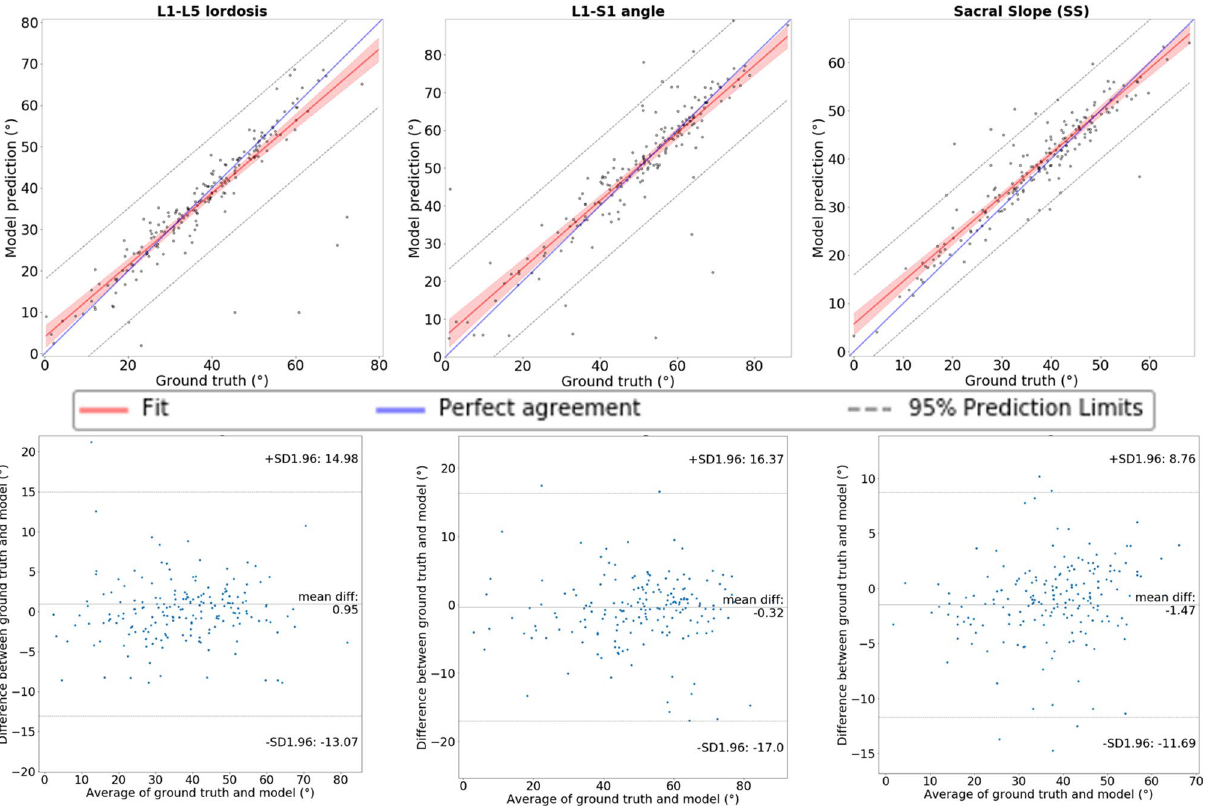
Figure 7. Regression analysis plots comparing the values of the ground truth angles and of the angles predicted by the 2-step model. From left to right: L1–L5 lordosis, L1–S1 angle and Sacral Slope (SS). The 95% confidence interval (dashed line), the 95% confidence limits of the prediction line (rendered in solid light red), the fit line (red line) and the perfect agreement (45° blue line) are shown. We can see that the fit is very close to the perfect